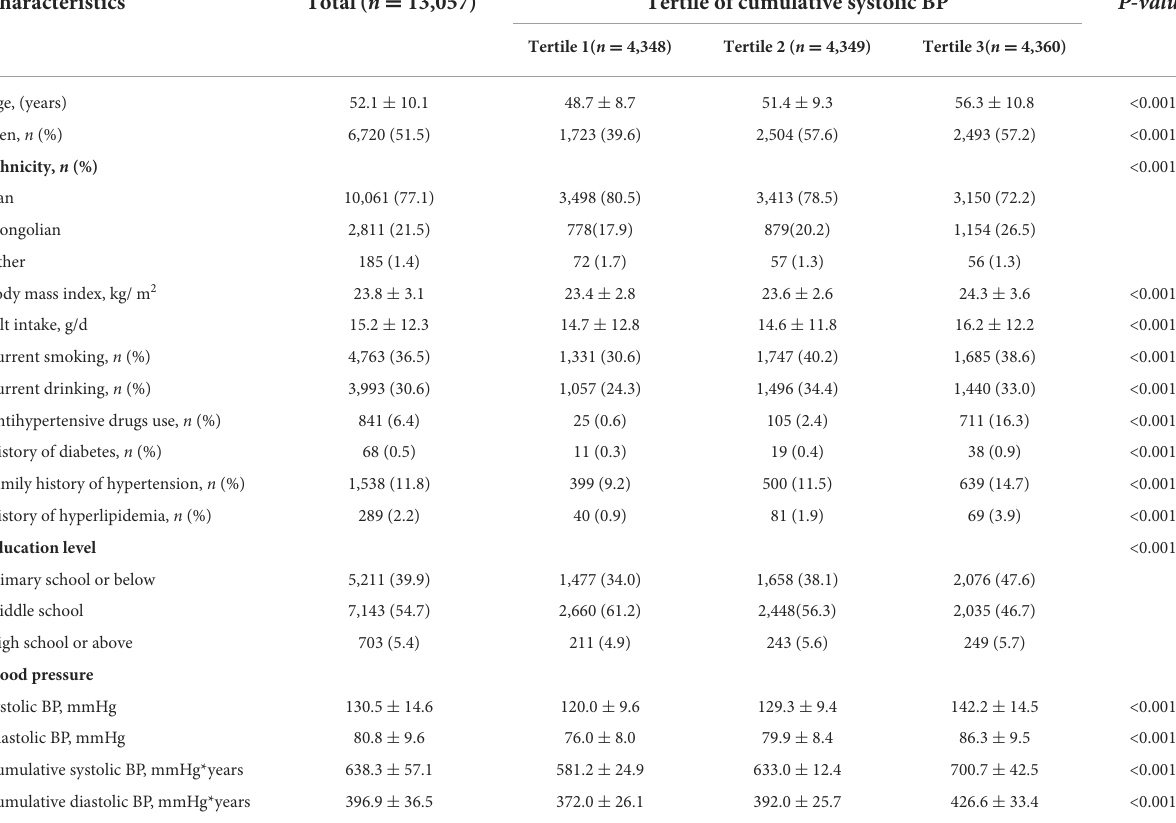
TABLE 1 The characteristics of the study population by the tertile of cumulative systolic BP.